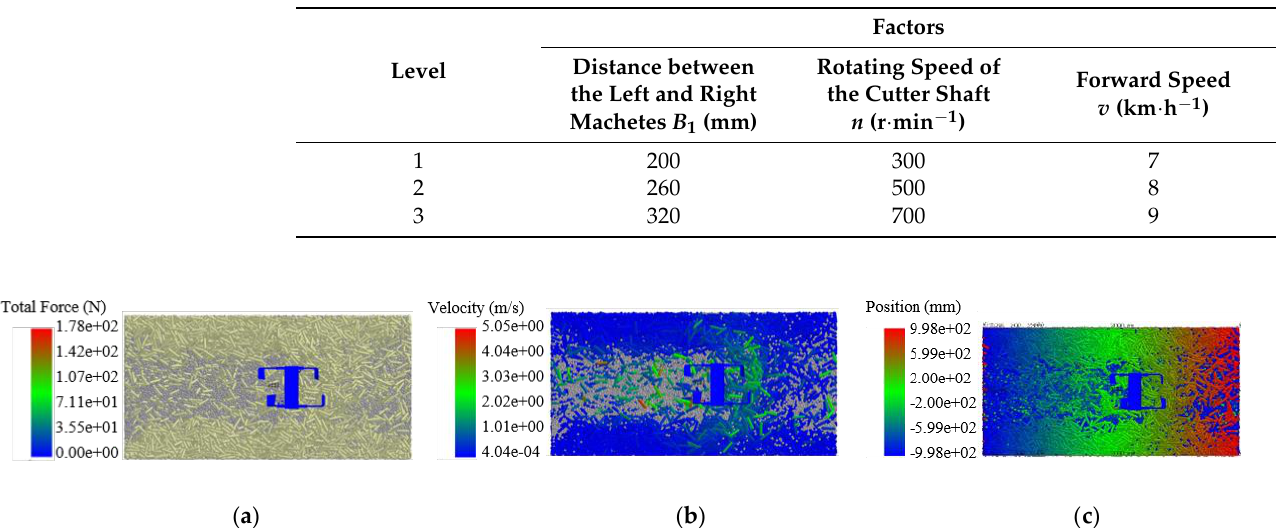
Table 2. Parameter settings for EDEM simulation of opposite-placed anti-blocking mechanism.